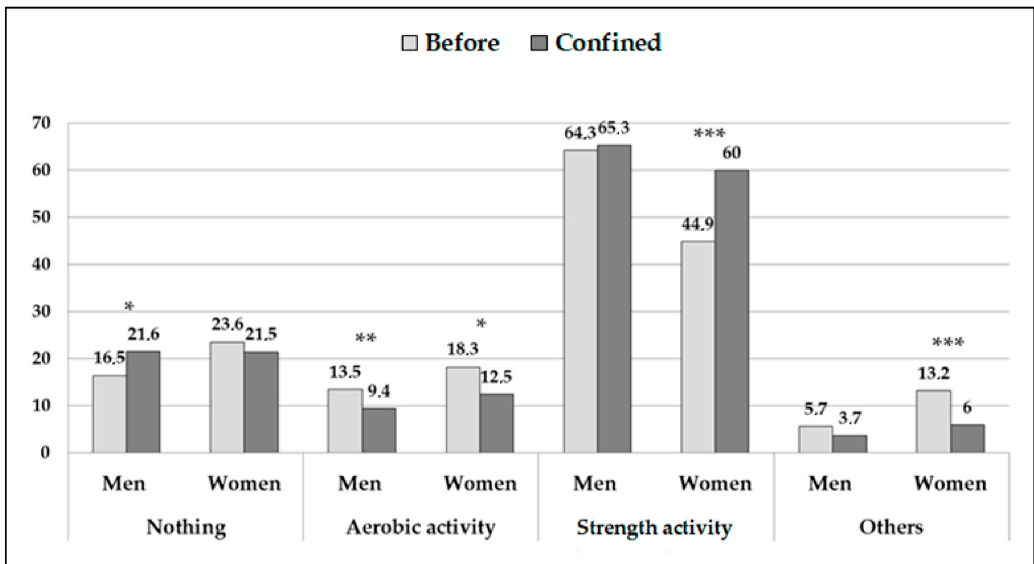
Figure 2. Type of physical activity carried out before and after the lockdown. Data provided in %. The asterisks indicate the significant di ff erences in the proportion of men and women within the same response option before and during lockdown: * p < 0.05; ** p < 0.01; *** p <